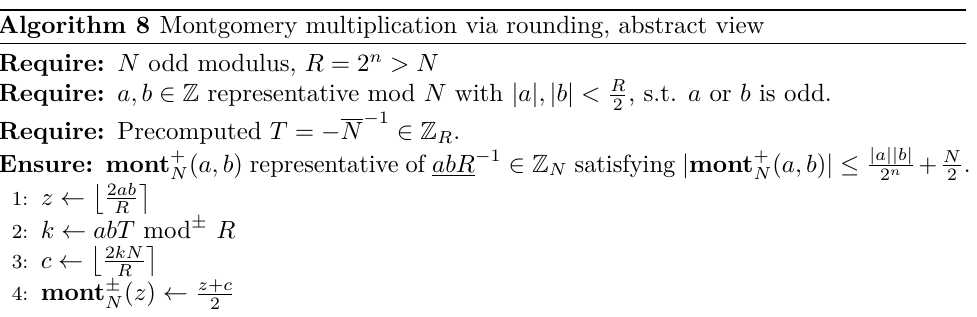
Algorithm 8 Montgomery multiplication via rounding, abstract view